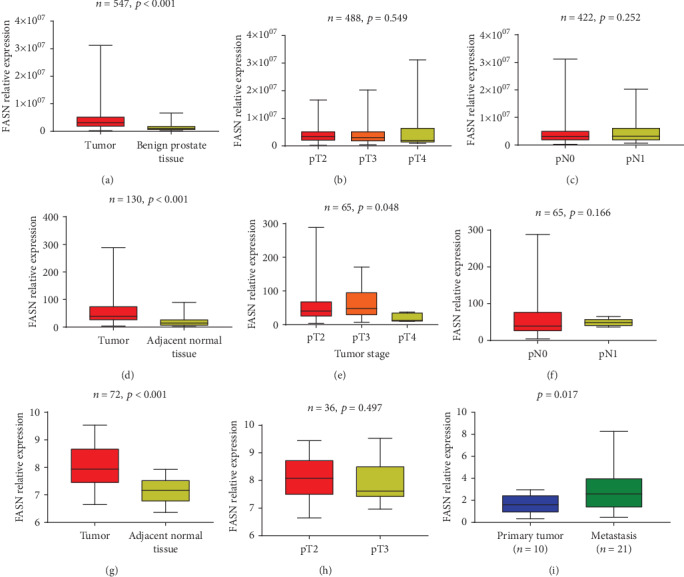
mRNA expression of FASN in TCGA public database (a–c), our sequencing data (d–f), GSE46602 (g, h), and GSE6752 (i). FASN expressions comparison between tumor and benign prostate tissue (a, d, g). FASN relative expression pattern among lymph node categories (c, f) and tumor stages (b, e, h). Comparison of FASN expression in primary prostate tumor tissue and metastasis (i) (note: T2: tumor stage 2; T3: tumor stage 3; T4: tumor stage 4; pN0: pathology lymph nodes 0; pN1: pathology lymph nodes 1).